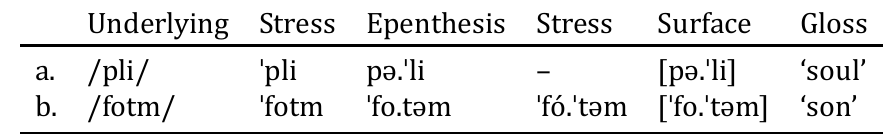
Table 12: Stress and epenthesis in nouns, based on Augusta